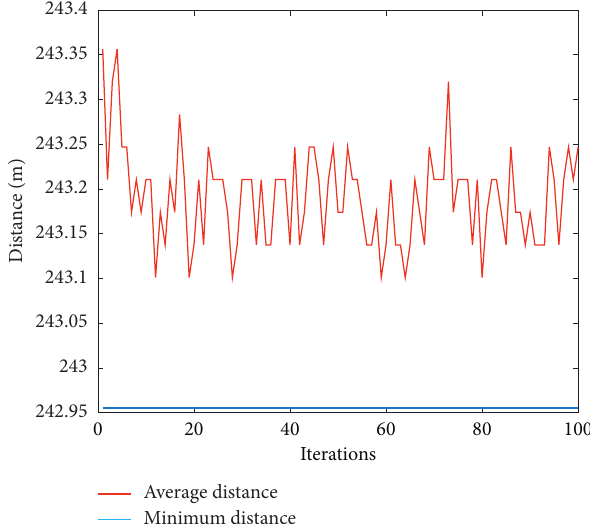
Figure 17: Predicted path length at the beginning of the fourth